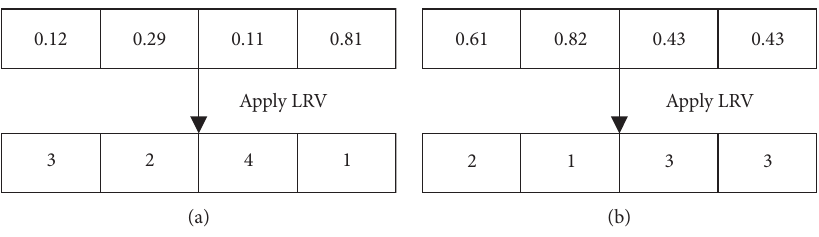
Figure 4: LRV representation. (a) Correct travel sequence and (b) wrong travel sequence.